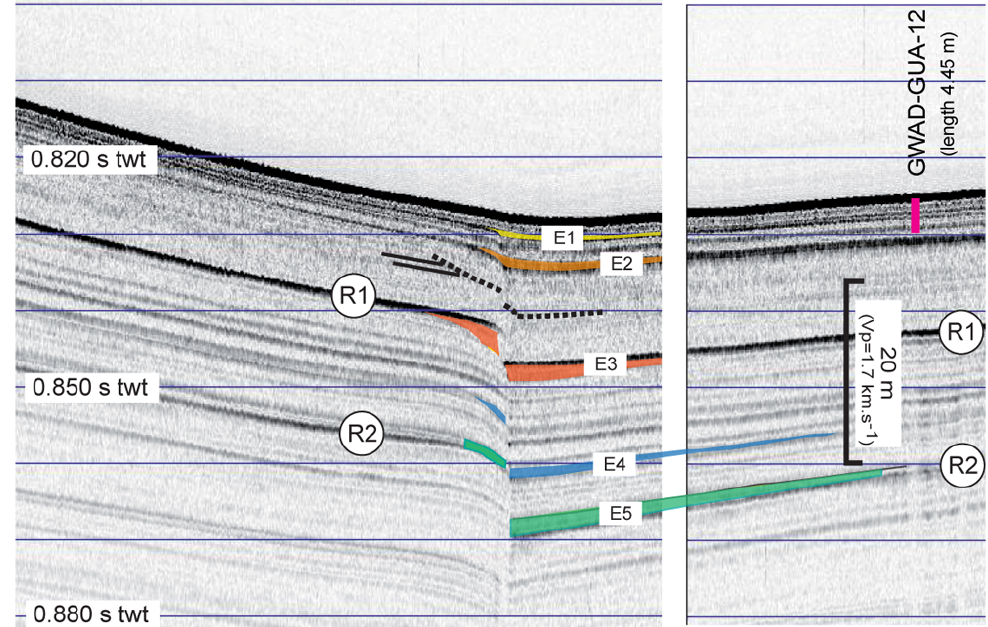
Fig. 4. Close up of profile 76 (location on Fig. 3c) displaying inferred co-seismic layers. R1 and R2 are major reflectors (possible tephra layers); E1 to E5 are inferred co-seismic sedimentary events. Two different situations may be distinguished with the used resolution: either an occurrence only on hanging wall, or an occurrence on both sides of the fault with an abrupt thickness increase on the hanging wall. Local collapse of the footwall may be observed (E3 and dashed